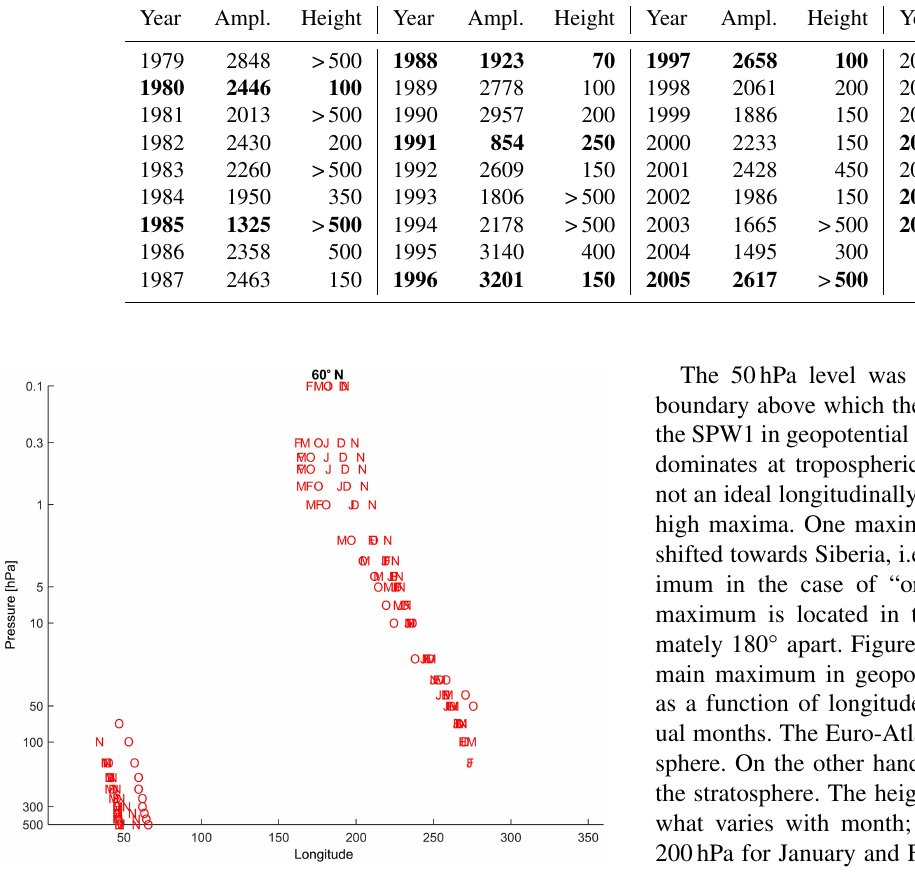
Table 1. SPW1 amplitudes at 1hPa (ampl. in metres) and heights where the Aleutian peak becomes dominant over the Euro-Atlantic peak (height in hPa) for 60 ◦ N and Januaries of all individual years (1979–2012). Extraordinary years are marked bold.